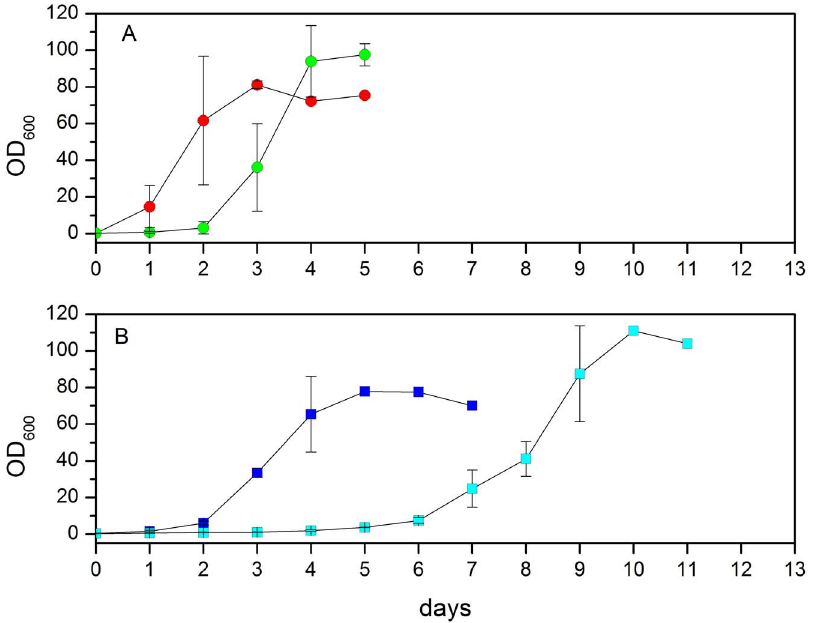
Figure 1. Growth curves of PichiaPastoris cells. (A) Growth of Pichia pastoris cells in a hydrogenated medium at 30 u C (red circle) and 18 u C (green circle). (B) Growth of P. pastoris cells in a deuterated medium at 30 u C (blue square) and 18 u C (cyan square). Errors bars represent the standard deviation from three independent growth curves.